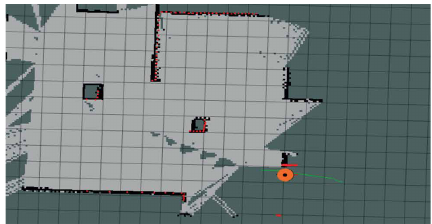
Figure 12: Schematic diagram of global path planning.